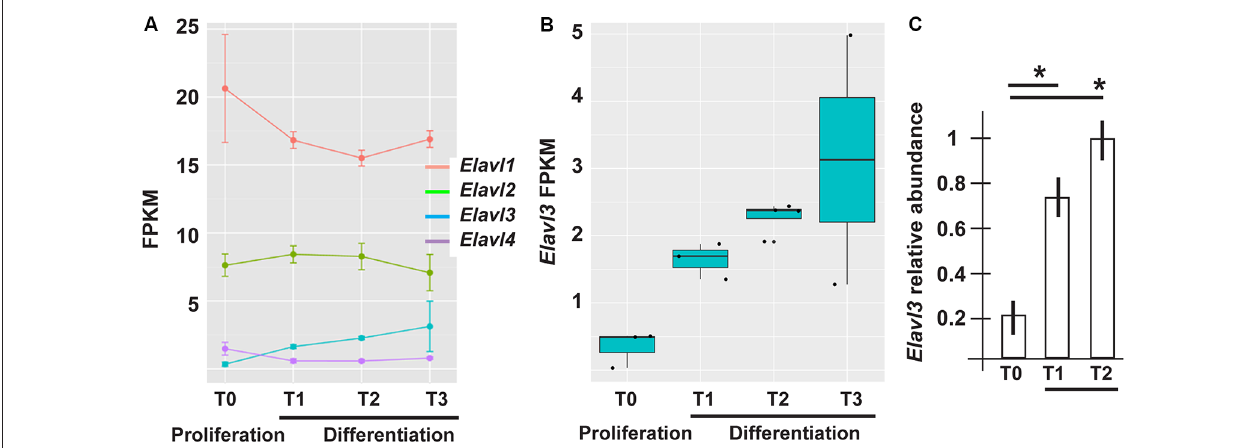
FIGURE 3 | Differential expression of RNA binding protein (RBP) of the Elavl family in differentiating ASN cells. (A) Expression of Elavl1 , Elavl2, Elavl3 and Elavl4 RBPs in proliferating (T0) vs. differentiating (T1, T2, T3) ASN cells, by RNAseq analysis. (B) Plotting of the same data as in (A) showing differential expression of Elavl3 mRNA in proliferating vs. differentiating ASN cells, by RNAseq analysis. (C) RealTime qPCR analyses on independent RNA samples to quantify the relative abundance of Elavl3 mRNA in ASN cells at T0, T1 and T2. Results are expressed as relative abundance, T2 is made = 1. ∗ p <